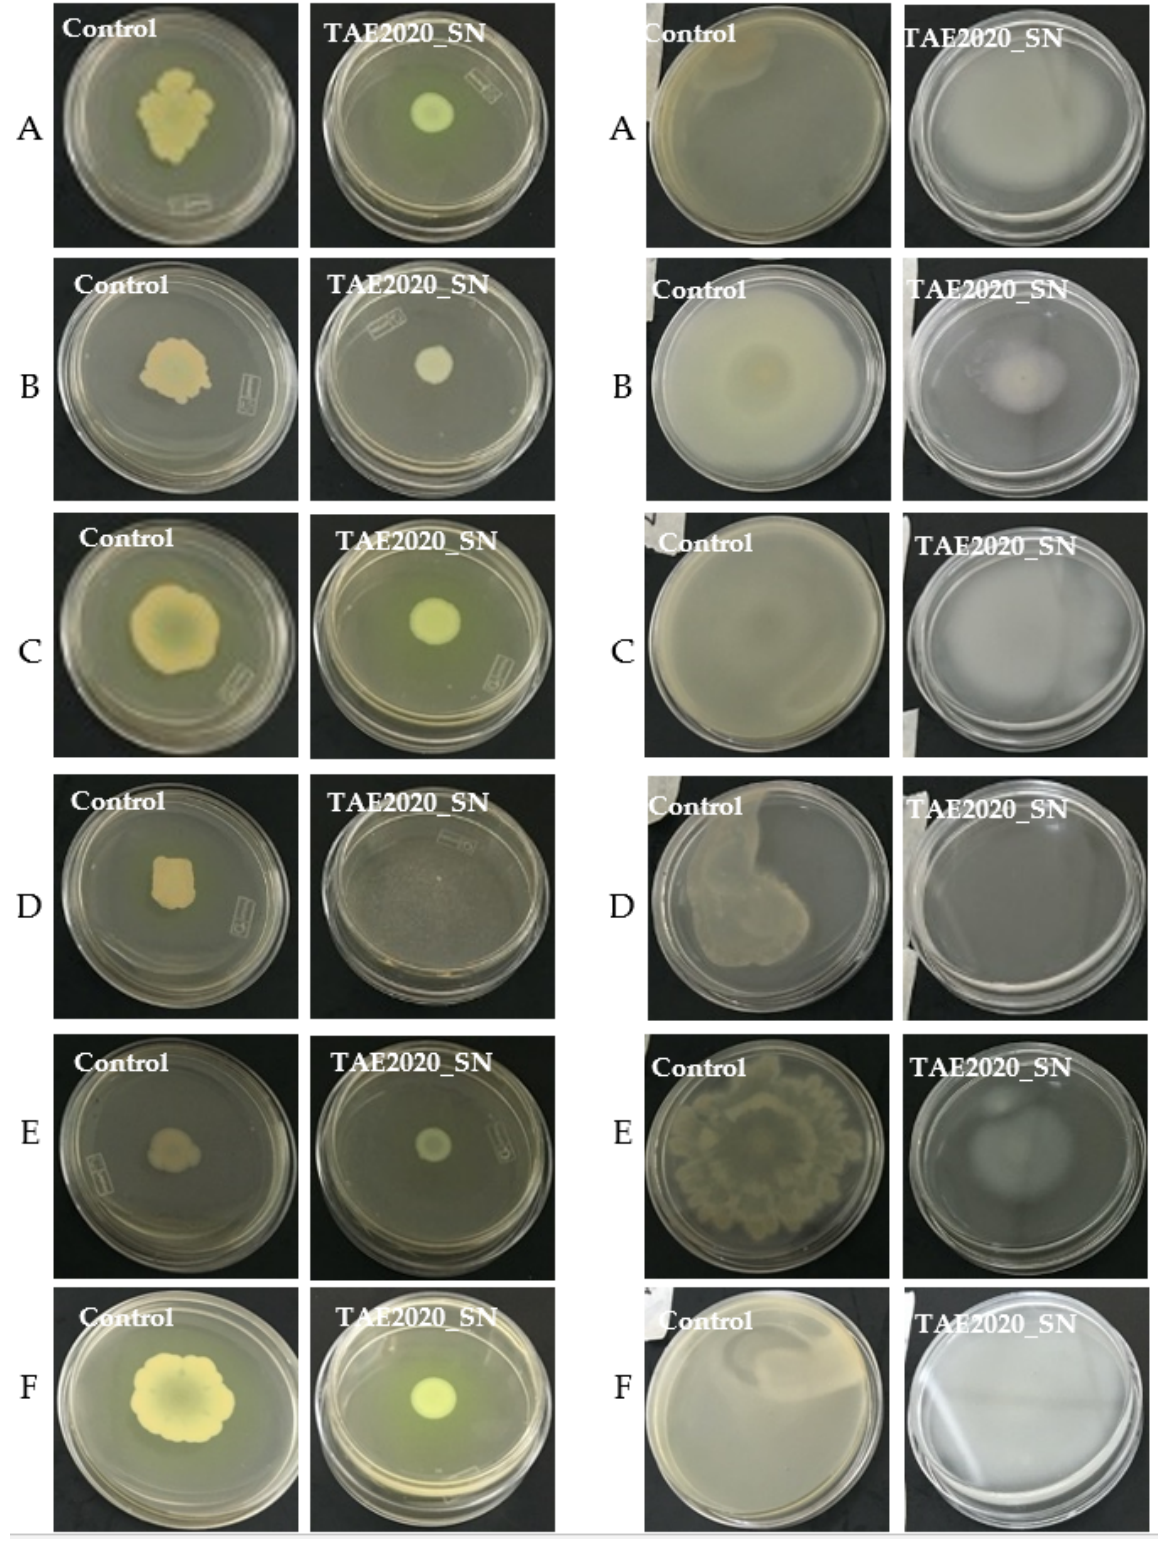
Figure 5. Motility assay. Left panel: Swarming inhibition assay of SN_TAE2020 on reference and clinical strains. ( A ) P. aeruginosa PA14; ( B ) P. aeruginosa 23P; ( C ) P. aeruginosa 27P; ( D ) P. aeruginosa 31P; ( E ) P. aeruginosa 32P; ( F ) P. aeruginosa 40P. Right panel: Swimming inhibition assay of SN_TAE2020 on reference and clinical strains. ( A ) P. aeruginosa PA14; ( B ) P. aeruginosa 23P; ( C ) P. aeruginosa 27P; ( D ) P. aeruginosa 31P; ( E ) P. aeruginosa 32P; ( F ) P. aeruginosa 40P.